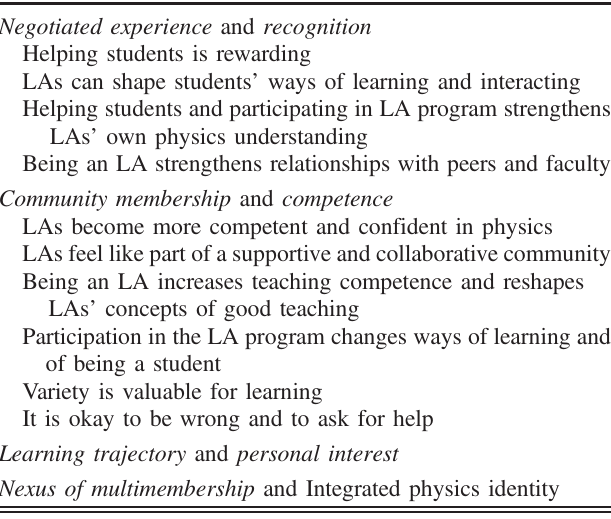
TABLE I. Summary of elements from blended identity frame- work with themes from